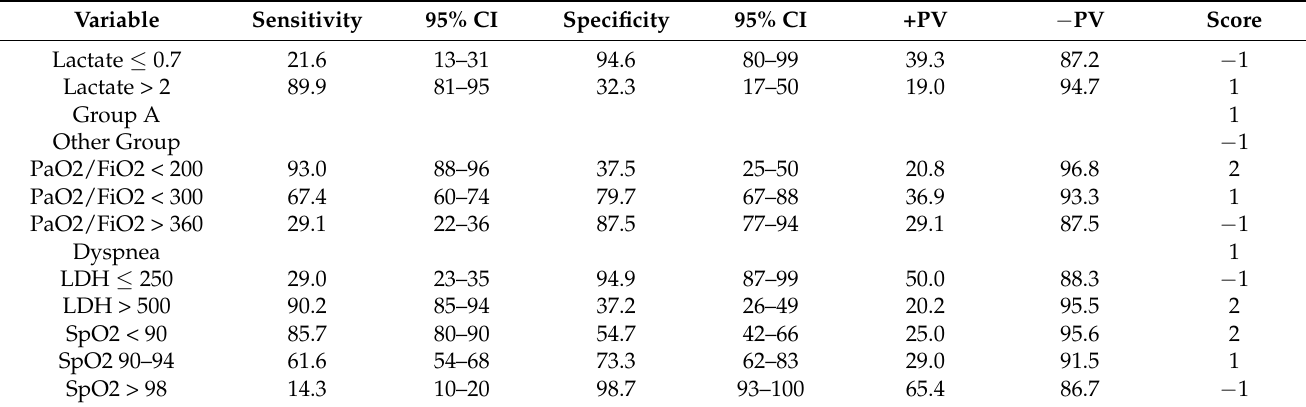
Table 4. GOL2DS score. Best cut off sensibility and specificity values for lactate, PaO2/FiO2, LDH and SpO2. A score was assigned for each cut off value. The sum of the scores for each variable determines the GOL2DS